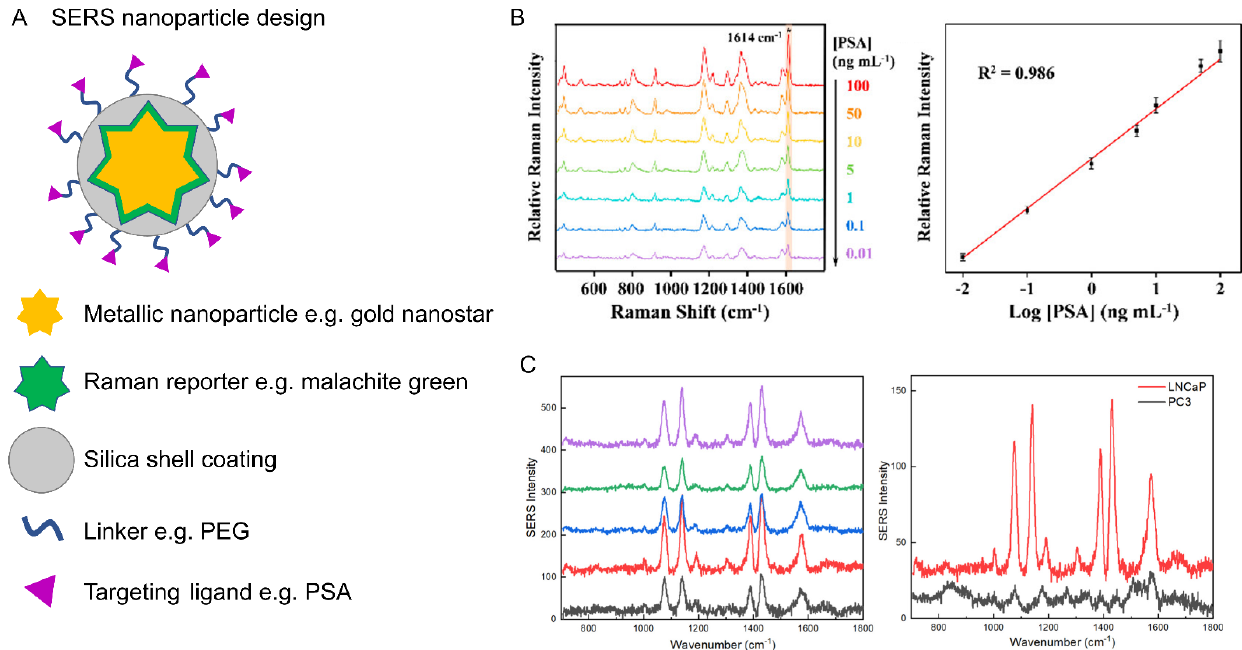
Figure 3. Biomolecular targeting using SERS detection. ( A ) Conceptual design of SERS nanoparticles for biological analysis. Typically, a gold nanoparticle, in this case a nanostar, is coated in a Raman reporter molecule. The reporter usually has a large Raman cross-section and may have an absorption matched to the excitation wavelength for enhanced detection sensitivity via resonance coupling effects. The nanoparticle may be coated in a thin silica shell, which stabilises the gold core and also provides a matrix for the Raman reporter. Specific targeting is achieved through a targeting ligand, e.g., antibodies, DNA, micro-RNA, etc., which can be introduced through a linker group. ( B ) Detection of prostate-specific antigen (PSA) using a microfluidic device with a SERS limit-of-detection at 0.01 ng/mL. Adapted from [9] with permission from the American Chemical Society (copyright 2019). ( C ) Detection of prostate-specific membrane antigen (PSMA) using SERS nanostars functionalised with 4-aminothiophenol in five different LNCaP cancer cells, which express PSMA, whilst a specificity comparison with SERS spectra from individual LNCaP and PC3 cells (which